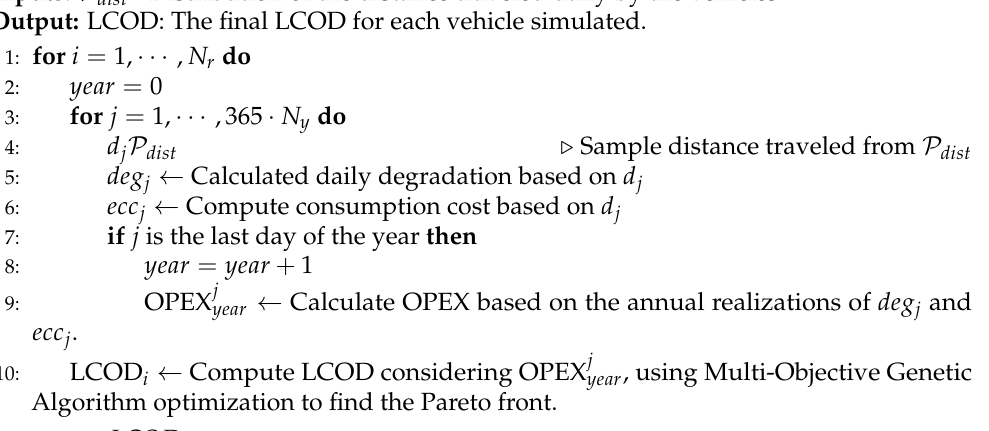
Algorithm 1 Monte Carlo simulation to predict the LCOD probability